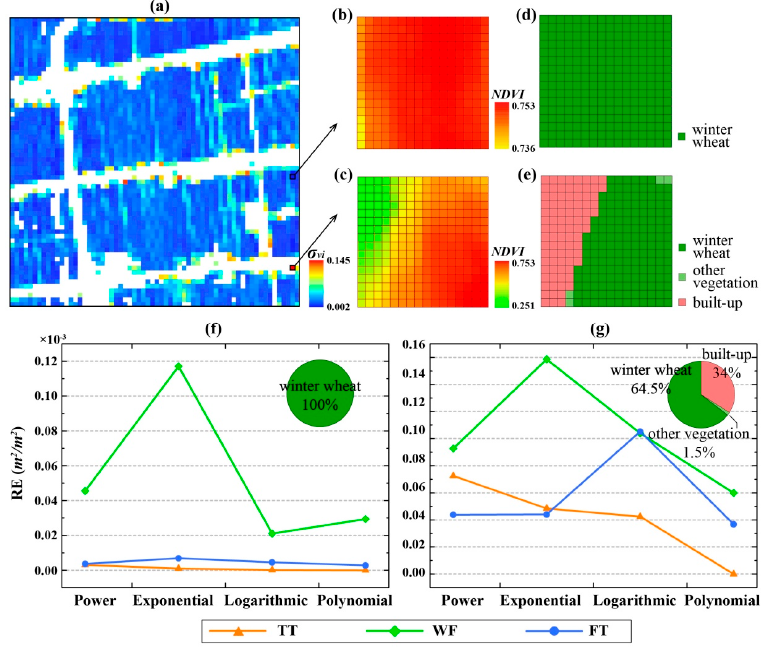
Figure 12. Comparison of LAI scaling bias correction in the extreme case of spatial heterogeneity. ( a ) The spatial heterogeneity of study area at 32-m resolution was obtained by the standard deviation of NDVI ( σ vi ). Within each pixel, there are 16 × 16 subpixels with spatial resolution of 2 m. NDVI distribution in the pixel of: ( b ) minimum σ vi ; and ( c ) maximum σ vi . The classes in the pixel of: ( d ) minimum σ vi ; and ( e ) maximum σ vi . By using TT (Taylor’s theorem), WF (Wavelet-Fractal technique), and FT (Fractal theory), the correction results of pixels with: ( f ) minimum σ vi ; and ( g ) maximum σ vi for the four LAI estimation models (power, exponential, logarithmic model and polynomial models) were obtained.